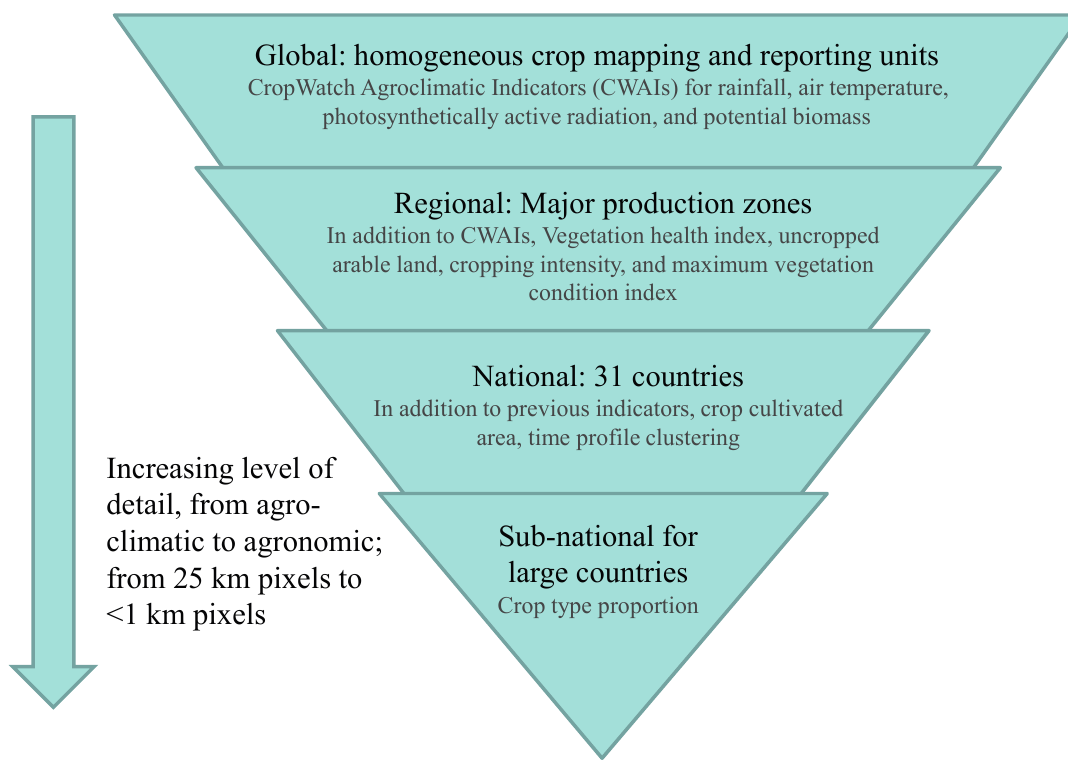
Figure 1. CropWatch hierarchical crop monitoring